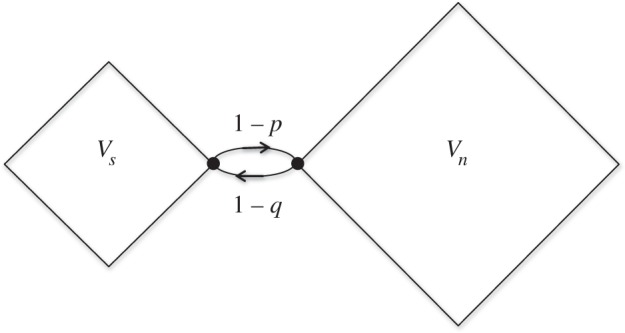
Single line graph.